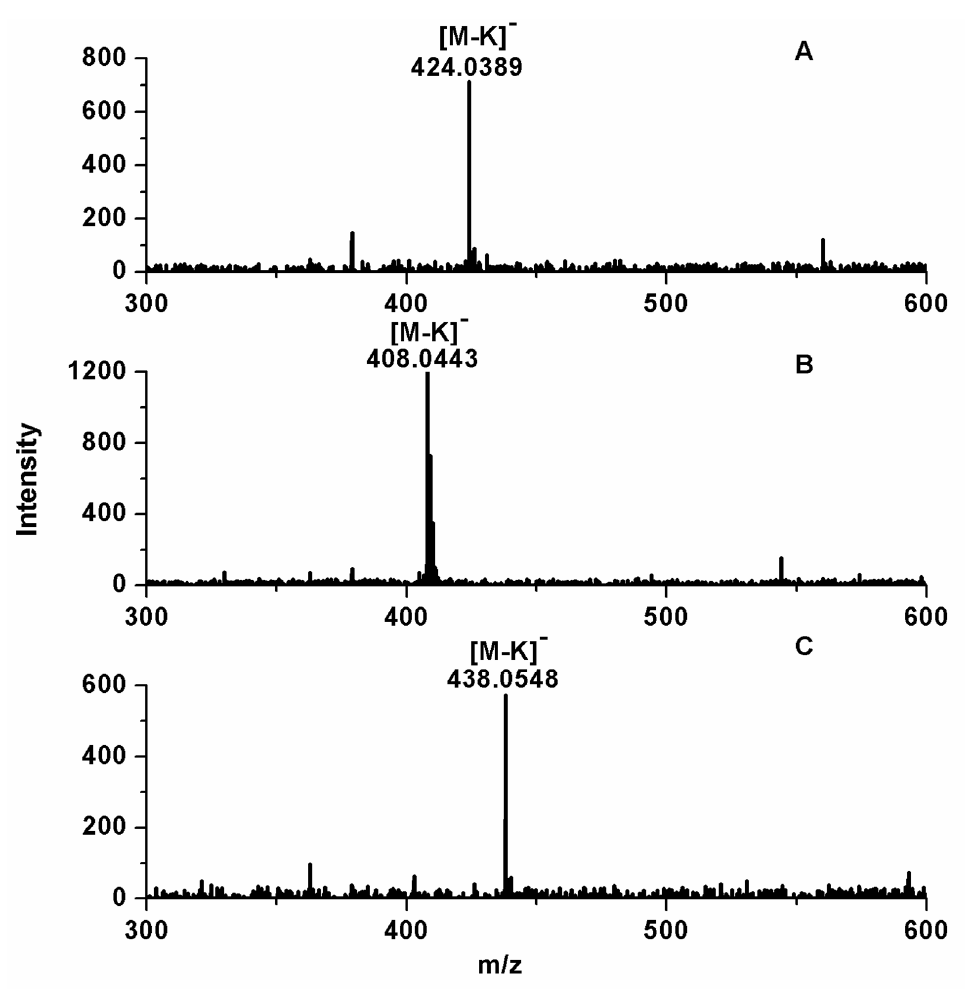
Figure 1. Negative ion electrospray ionization-mass spectra of p -hydroxybenzyl glucosinolate ( A ), benzyl glucosinolate ( B ), and m -methoxybenzyl glucosinolate ( C ) in GLS from Maca, respectively.